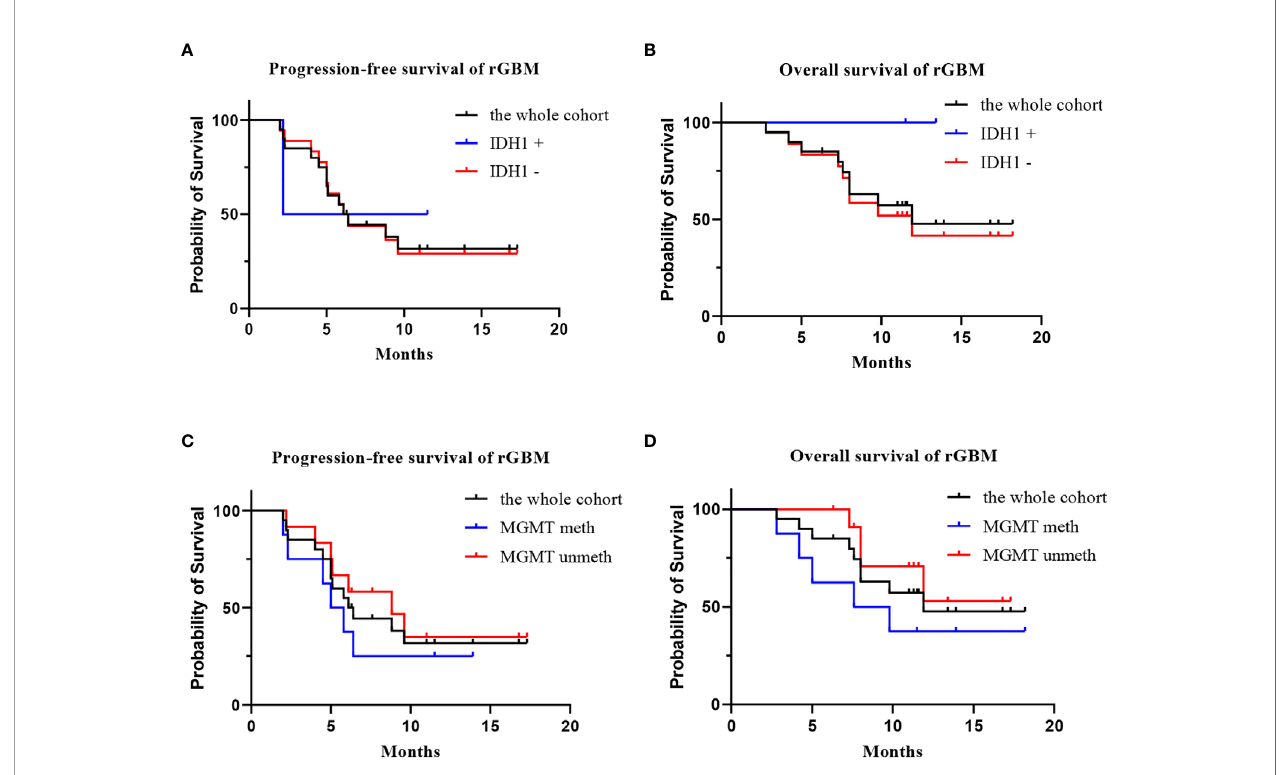
FIGURE 2 | The survival analysis of the 20 patients with rGBM who received anlotinib and TMZ treatment. [ (A) progression-free survival of IDH1+ group, IDH1 − group, and the whole cohort; (B) overall survival of IDH1+ group, IDH1 – group, and the whole cohort; (C) progression-free survival of MGMT meth group, MGMT unmeth group, and the whole cohort; (D) overall survival of MGMT meth group, MGMT unmeth group, and the whole